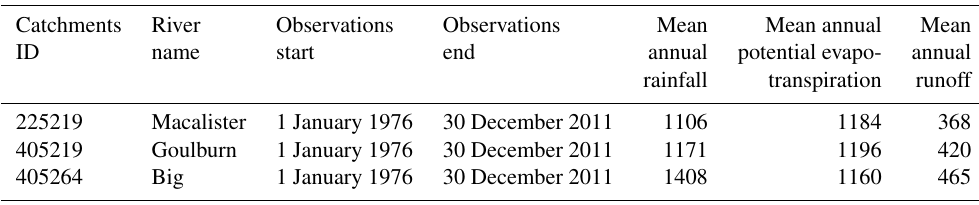
Table 2. Comparison of catchments attributes in terms of mean annual rainfall (mm), mean annual evaporation (mm), and mean annual runoff (mm) for 1976–2011.